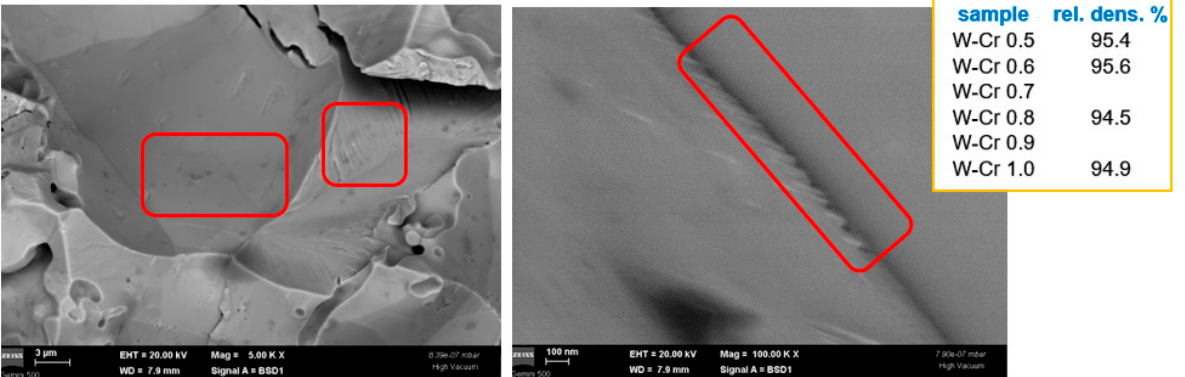
Figure 6. Cross-section SEM images obtained using a backscattered electron detector for W-Cr materials. Darker small spots on the W grain surface, as identified in the red frames ( left ), result from W-Cr solid solution formation, and similar smaller points are also detected between grains as seen in the red frame ( right ). The inset summarizes the density values of these materials.